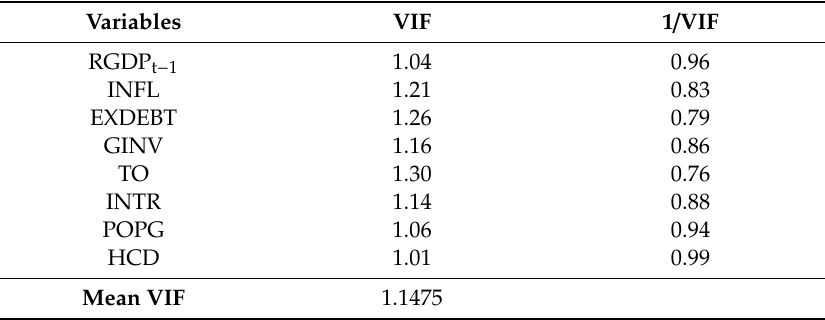
Table 3. Results of the Variance Inflation